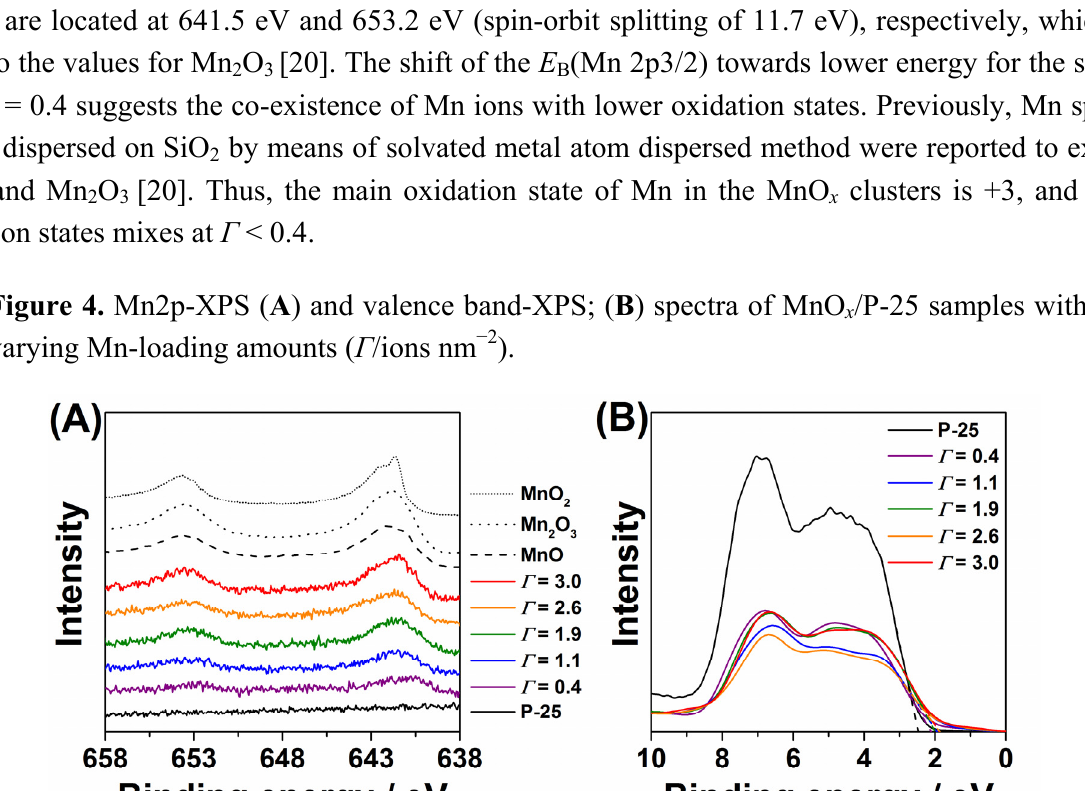
/P-25 samples with x